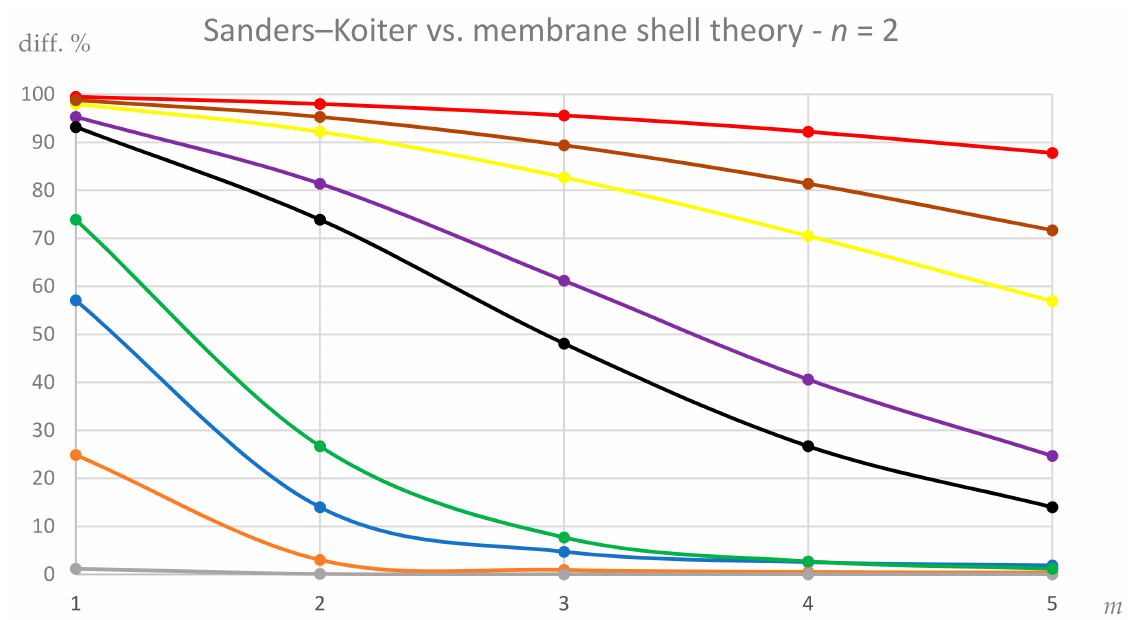
Figure 2. Simply supported DWCNT of Table 1 with different values of aspect ratio L / R 2 and thickness ratio R 2 / h . Shell- like modes ( n = 2). Comparisons between extended Sanders–Koiter and simplified membrane shell theories, where L / R 2 = 10, R 2 / h = 25;